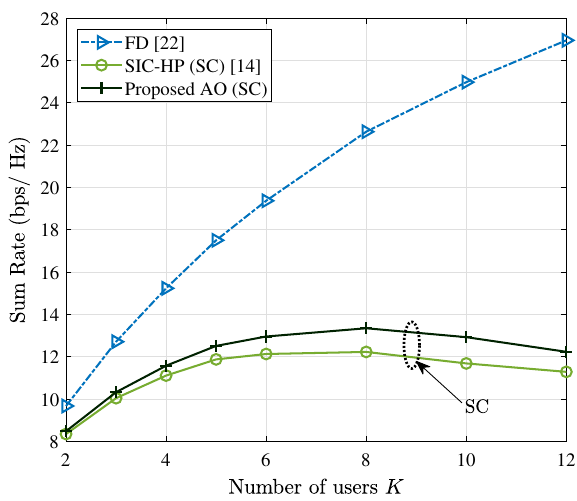
Fig. 5 Sum rate versus number of users K . We set N t = 60 , M = 12 , and SNR = 0 dB